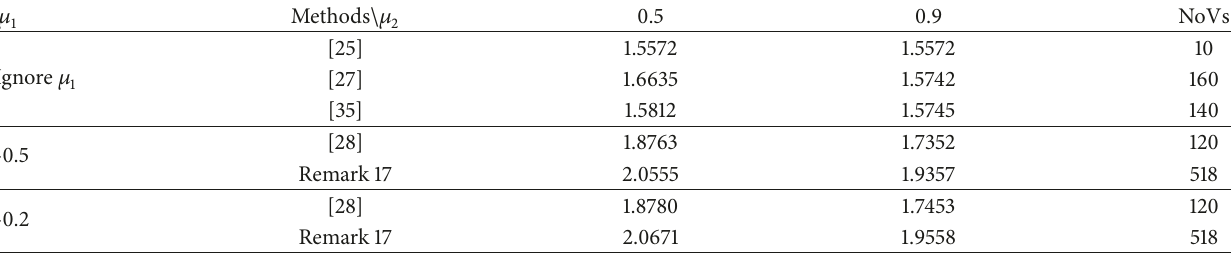
Table 3: MADUBs ℎ for 𝜏 𝑑 = 0.6 and different 𝜇 1 and 𝜇 2 (Example 3).